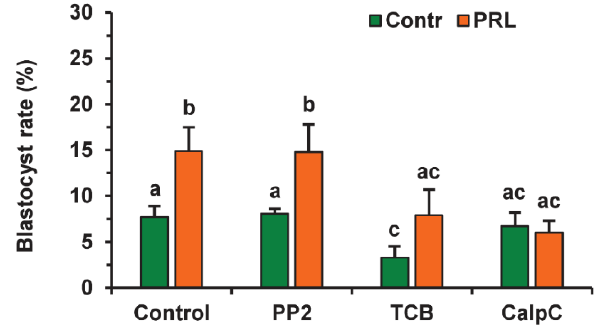
Figure 13. Effects of PRL (50 ng/mL) during the 12 h aging of bovine CEOs in the presence and in the absence of PP2 (10 µ M), triciribine (TCB, 25 µ M), and calphostin C (CalpC; 0.5 µ M) on the subsequent blastocyst formation. Data represent means ± SEM of 6–7 replicates using 177–212 oocytes per treatment. Means marked with different letters differ significantly (at least p < 0.05).